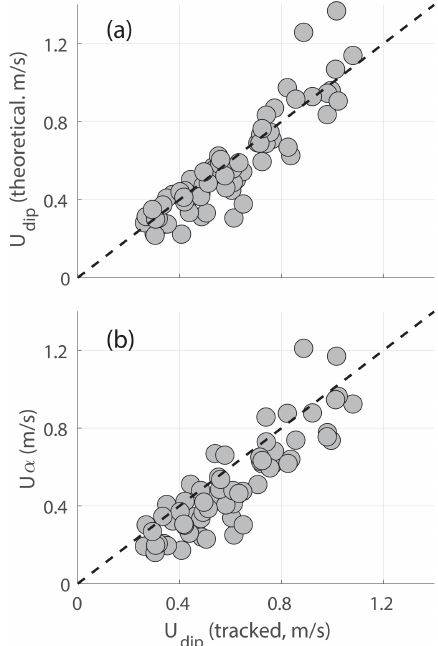
Figure 16. The dipole velocities obtained from tracking (on the x axis) plotted against (a) the theoretical dipole velocities (Eq. 15) and against Uα (Eq. 18) in the lower panel. The tracked velocities, theoretical velocities, and α are averaged over the time period when the dipole is located inside the sink